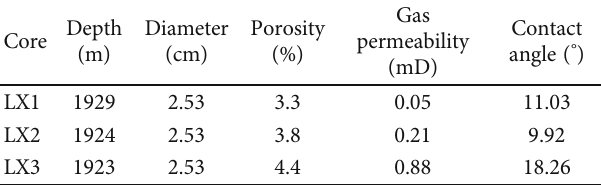
Figure 1: Three tight gas sandstone cores from Linxing area, Taiyuan Group, Ordos Basin. Table 1: Petrophysical properties of the three tight gas